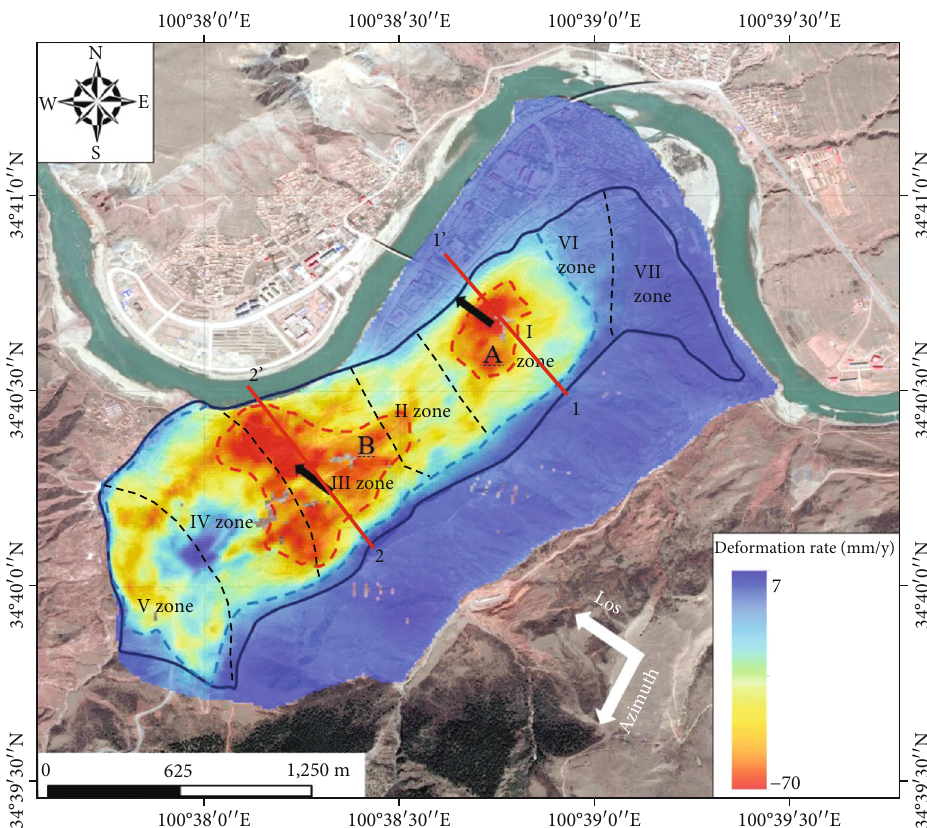
Figure 8: The annual average rate of deformation of the Quwajiasa